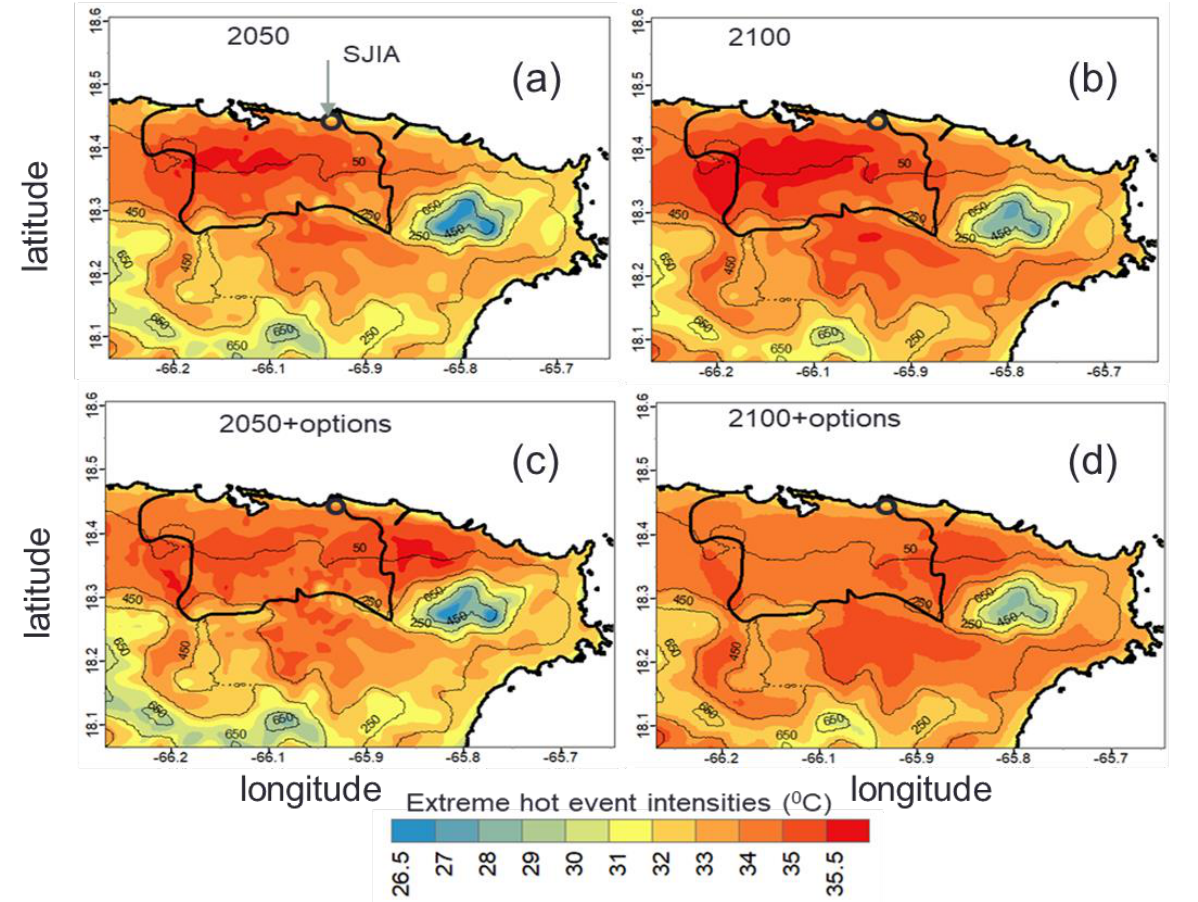
Figure 6. Extreme heat event intensities (representing greater than 95%, i.e., >32.8 °C) for middle of century and end of century with and without energy mitigation measures. ( a ) Extreme heat event intensity for 95% for 2050 ( b ) for 2100 ( c ) 2050 with energy mitigation options ( d ) for 2100 with mitigation measures.